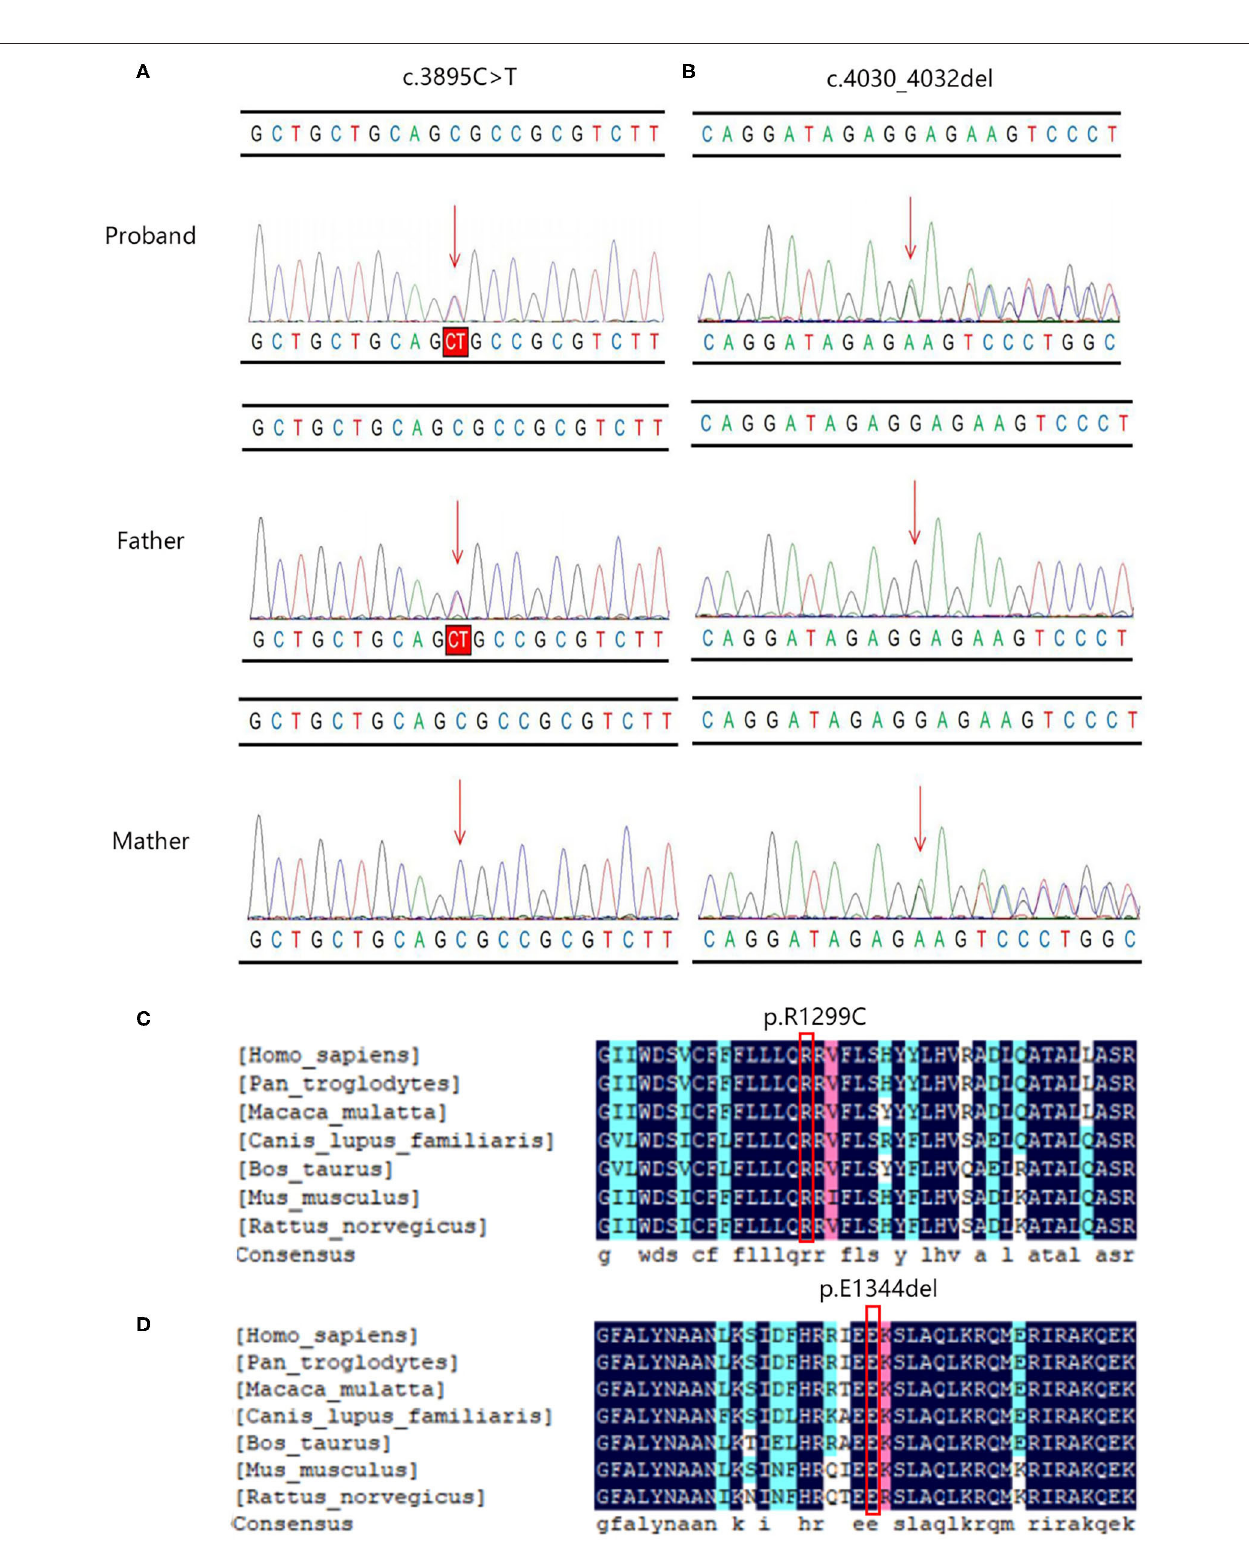
FIGURE 2 | The Sanger sequencing and conservation analysis of PIEZO1 variants. The chromatograms demonstrated the compound heterozygous status of (A) c.3895C > T and (B) c.4030_4032del in the PIEZO1 gene in the proband, proband’s father, and proband’s mother. The position of the variant or the corresponding wild type nucleotide are labeled with red arrows. Conservation analysis shows that the affected amino acids at positions 1,229 (C) and 1,344 (D) are located in a highly conserved region across species.